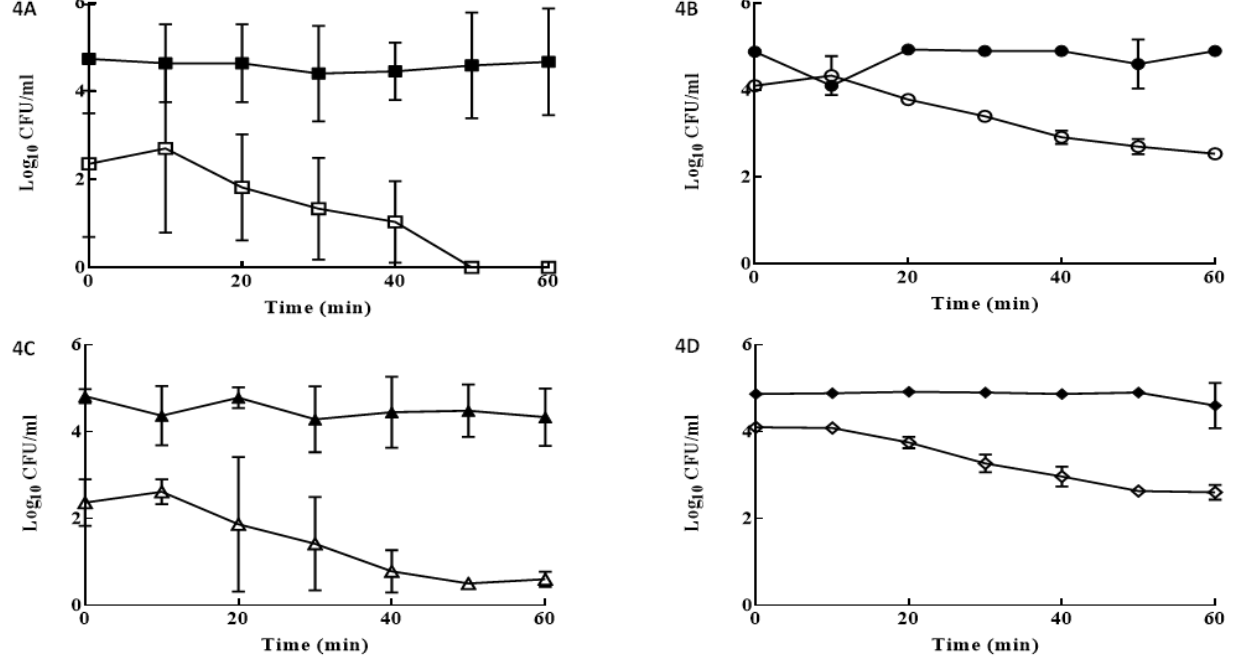
Figure 4. Sporicidal effect of 2% v / v treatment 4 at 0, 10, 20, 30, 40, 50, and 60 min contact times for ( 4A ) C. estertheticum spores in SDW ( (cid:3) )/Control ( (cid:4) ); ( 4B ) C. estertheticum spores in BSA